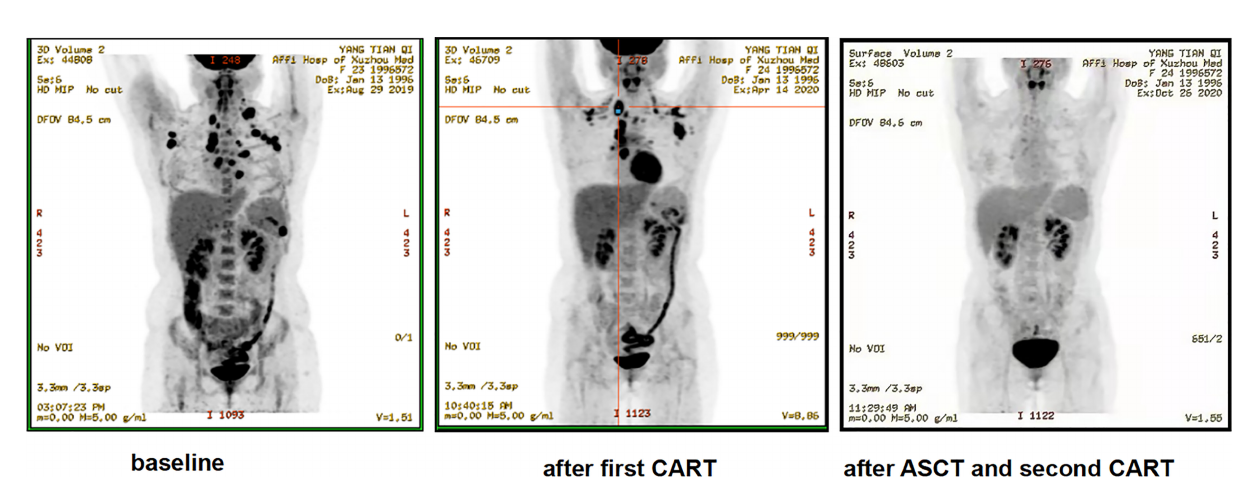
FIGURE 4 | Representative clinical response images of the patient after anti-CD30 CAR-T cell infusion (patient 8). The second cycle of anti-CD30 CAR-T cells was infused 2 weeks after the autologous stem cell transplantation (ASCT). Positron emission tomography – computed tomography scans demonstrated a signi fi cant shrinkage of masses after the fi rst cycle of anti-CD30 CAR-T cell infusion and complete disappearance of abnormal lymph nodes after ASCT and the second cycle of anti-CD30 CAR-T treatment.